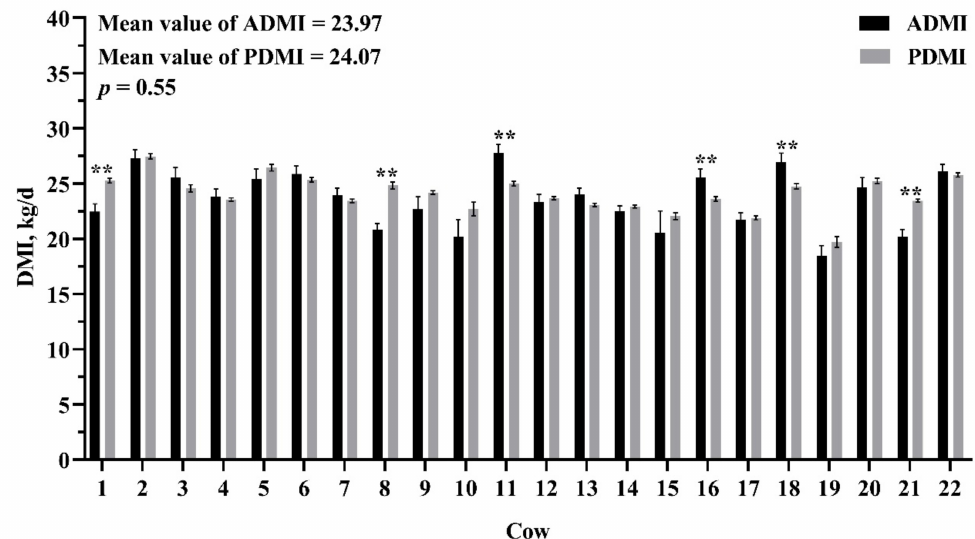
Figure 4. Comparison of actual dry matter intake (ADMI) and predicted dry matter intake (PDMI) in every cow in the validation dataset. Bars indicate SEM. The ** indicate a significant difference between ADMI and PDMI in the individual cow at p <